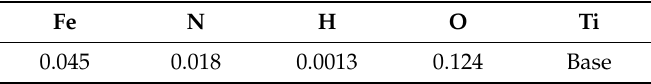
Table 2. The chemical composition of TA2 pure titanium